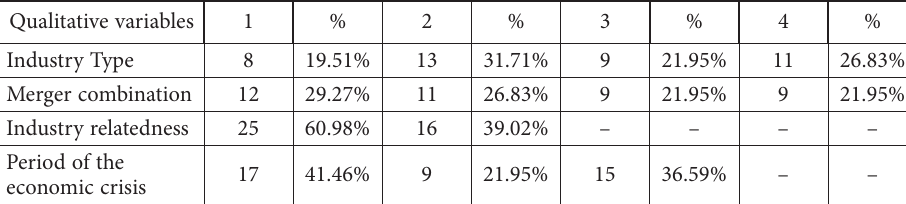
Table 2. Summary of qualitative variables of the sample